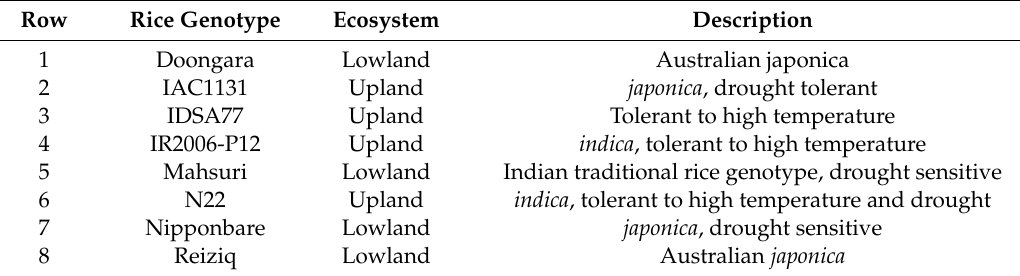
Table 3. Details of rice genotypes analyzed in this